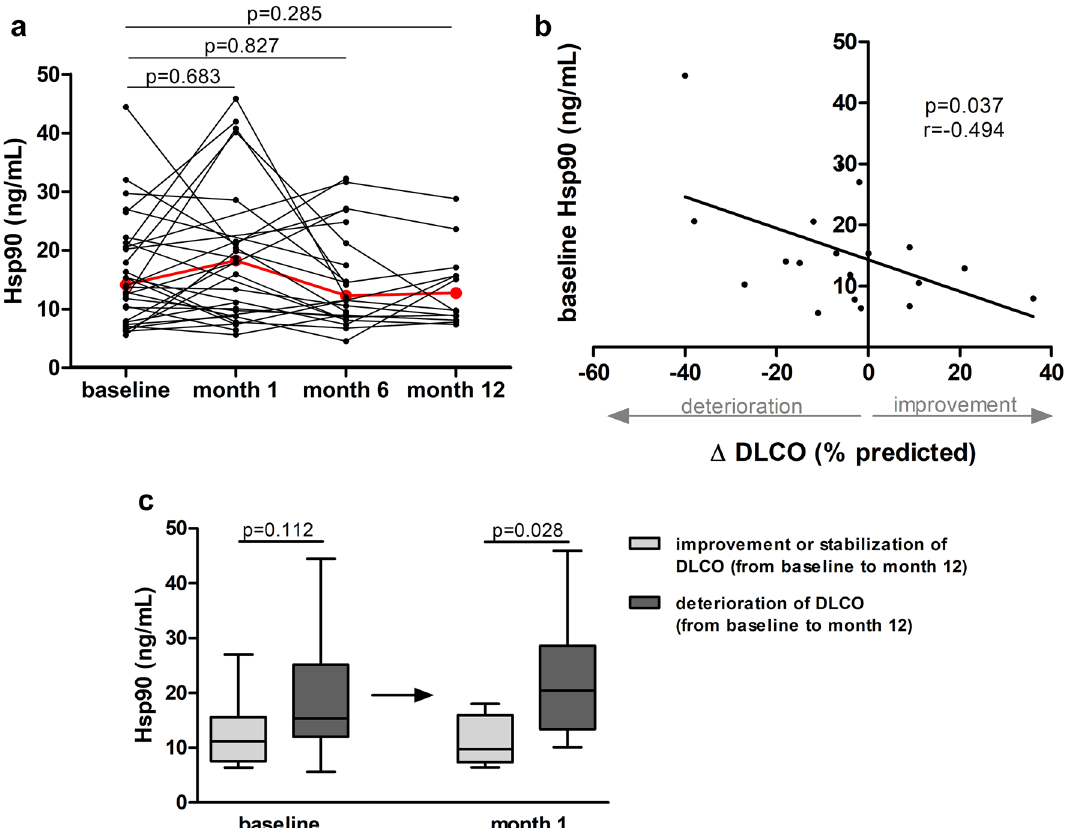
Figure 3. Longitudinal analysis of Hsp90 plasma levels in patients with SSc-ILD treated with cyclophosphamide. ( a ) No significant differences in plasma Hsp90 were detected between baseline and after 1, 6, and 12 months of therapy with cyclophosphamide in patients with systemic sclerosis-associated interstitial lung disease (SSc-ILD). The red line represents the median. Friedman’s test was used for all comparisons. ( b ) Lower baseline levels of plasma Hsp90 were significantly associated with larger improvement in diffusing lung capacity for carbon monoxide at month 12 from baseline (ΔDLCO% predicted) upon cyclophosphamide treatment. ( c ) Differences in plasma Hsp90 levels at baseline and one month thereafter in patients grouped according to the course of pulmonary function during the observation time, classified by deterioration and stabilization or improvement of DLCO% predicted at month 12 with respect to baseline. Descriptions of deterioration, stabilization, and improvement are stated in the text. Values are presented as box plots: the boxes represent the 25th–75th percentiles, the lines within the boxes represent the median, and the whiskers represent minimum to